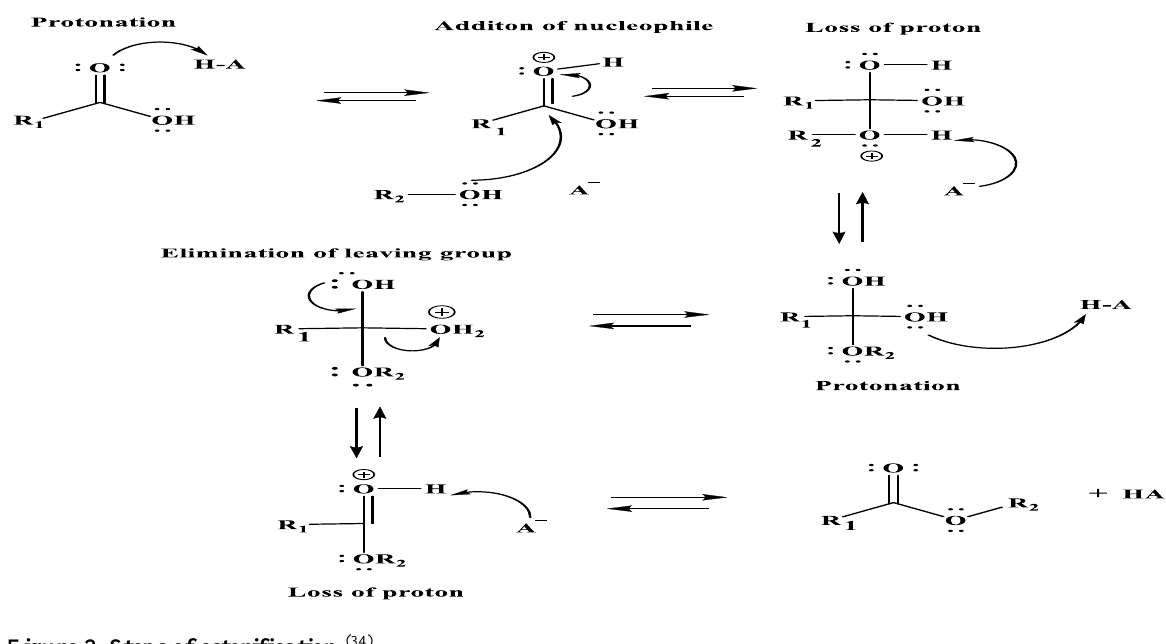
Figure 2. Steps of esterification. (34) Compound (1) was characterized by carbonyl group of aromatic ester at 1686cm -1 in its FTIR spectrum and 1 HNMR signals confirmed the presence of COOCH 3 at 3.80